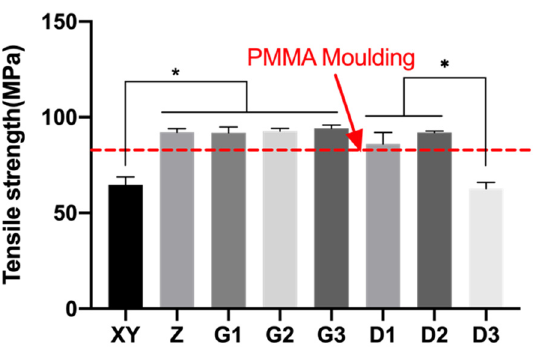
Figure 11. Mean and standard deviations of tensile strength of 3D-printed PEEK. * p < 0.05.